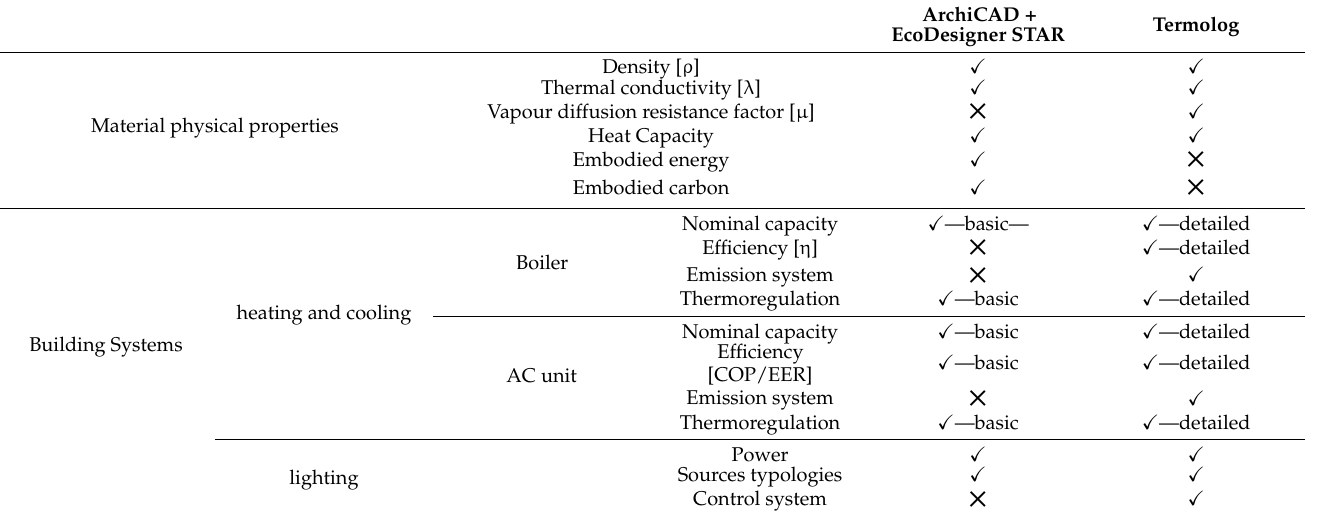
Table 3. Comparison with Termolog software.